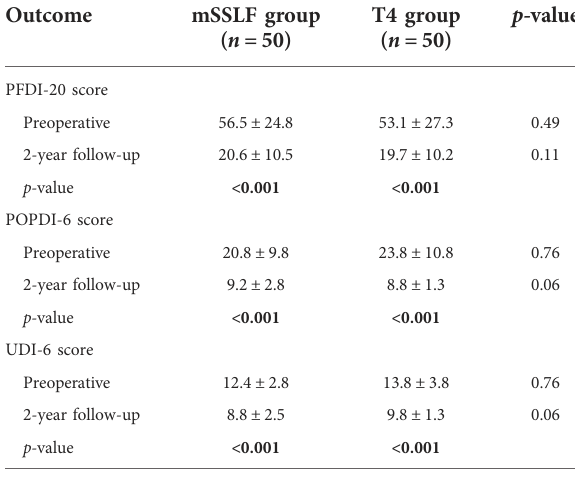
TABLE 4 Functional outcomes measured by the PFDI-20 at the 2-year follow-up.